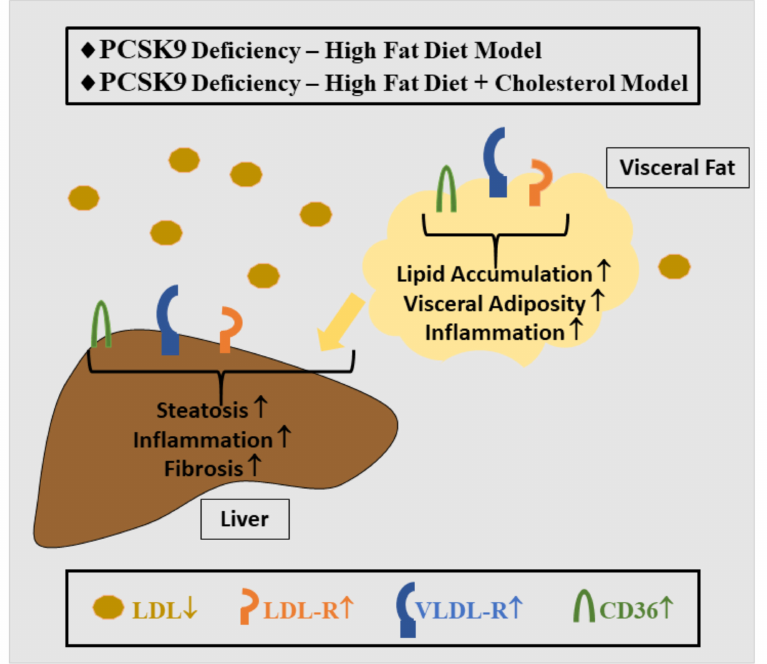
Figure 4. Role of PCSK9 in experimental models of NAFLD. PCSK9 deficiency in mice is associated with low circulating LDL levels and higher LDL-R, VLDL-R and CD36 expression in the liver and visceral fat depots. Separate studies reported PCSK9 deficiency to worsen liver injury. Visceral adiposity was observed in some studies [29,137,144,148–150]. Of note, a similar phenotype was also described in mice overexpressing PCSK9 [29]. Whether aberrantly high or low levels of PCSK9 cause a similar phenotype in the NAFLD model will be resolved in future